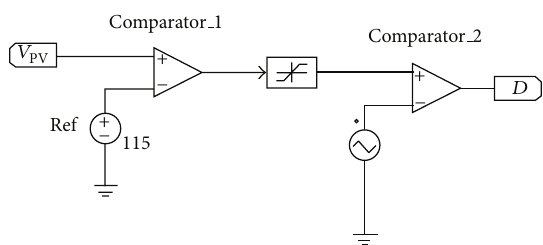
Figure 4: Irradiance profile ( 𝑆 ), temperature profile ( 𝑇 ), extracted power ( 𝑃 and average efficiency obtained with fixed duty cycle.